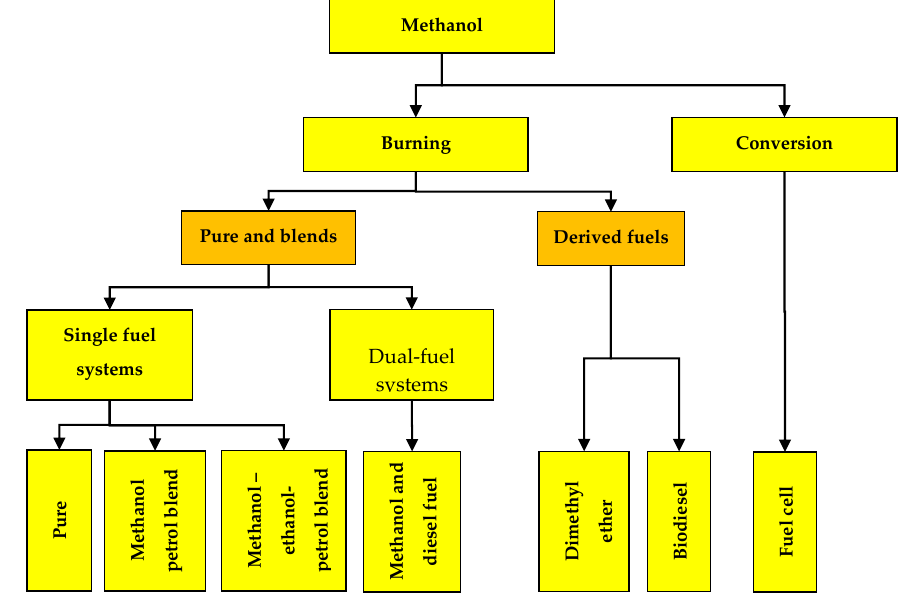
Figure 3. Methanol utilization as vehicle fuel.